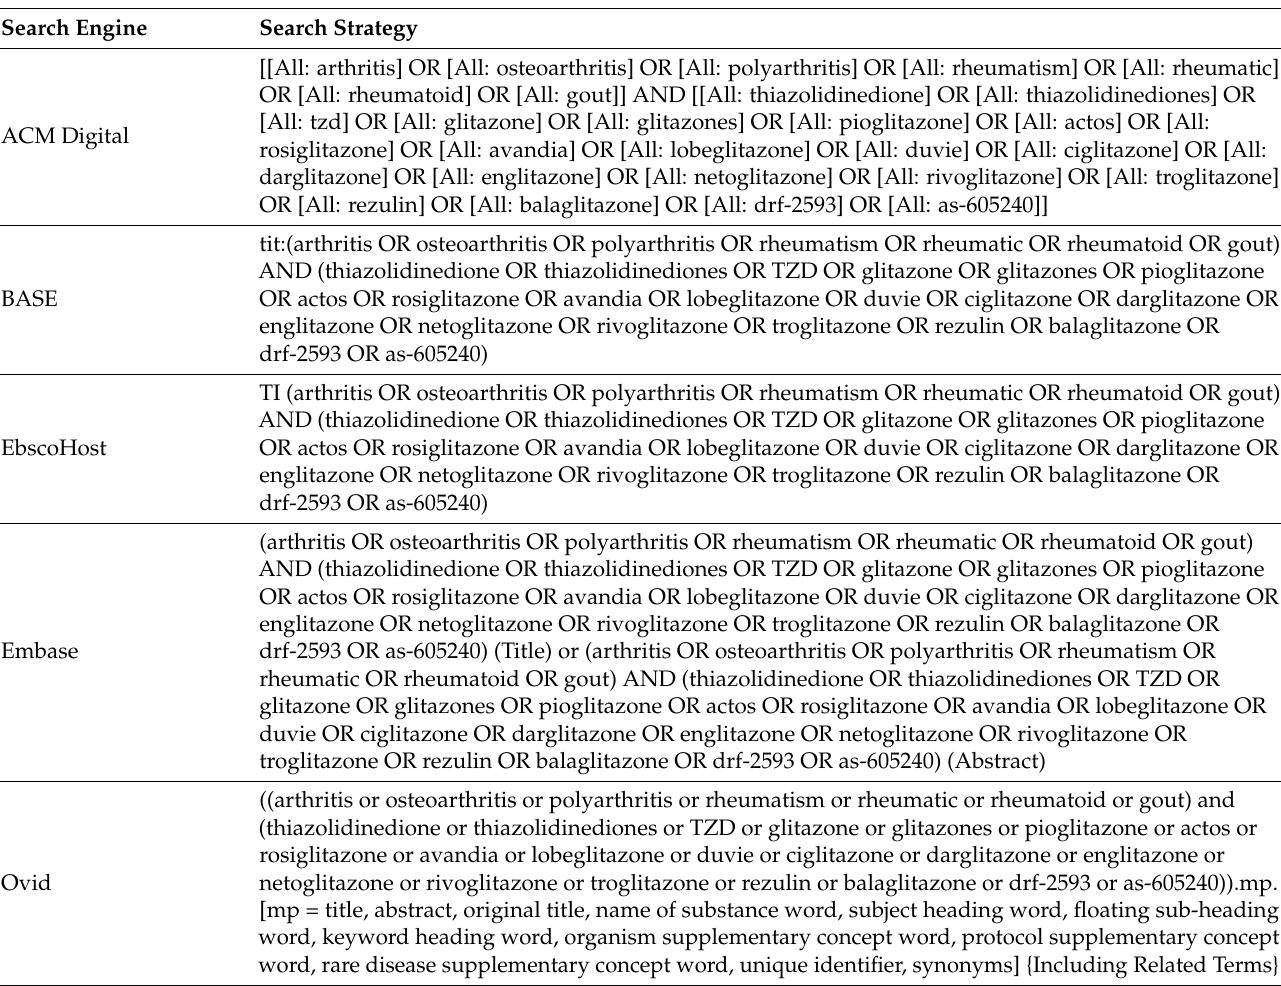
Table A1. Search engines and search